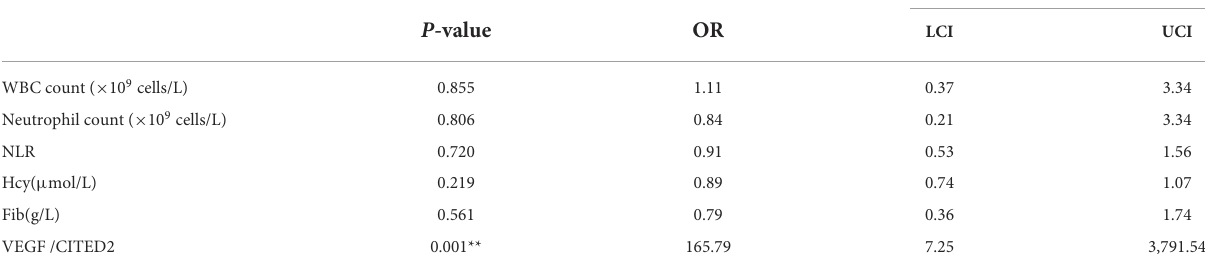
TABLE 5 Multivariate logistic regression analysis of collateral circulation-related factors in AIS.